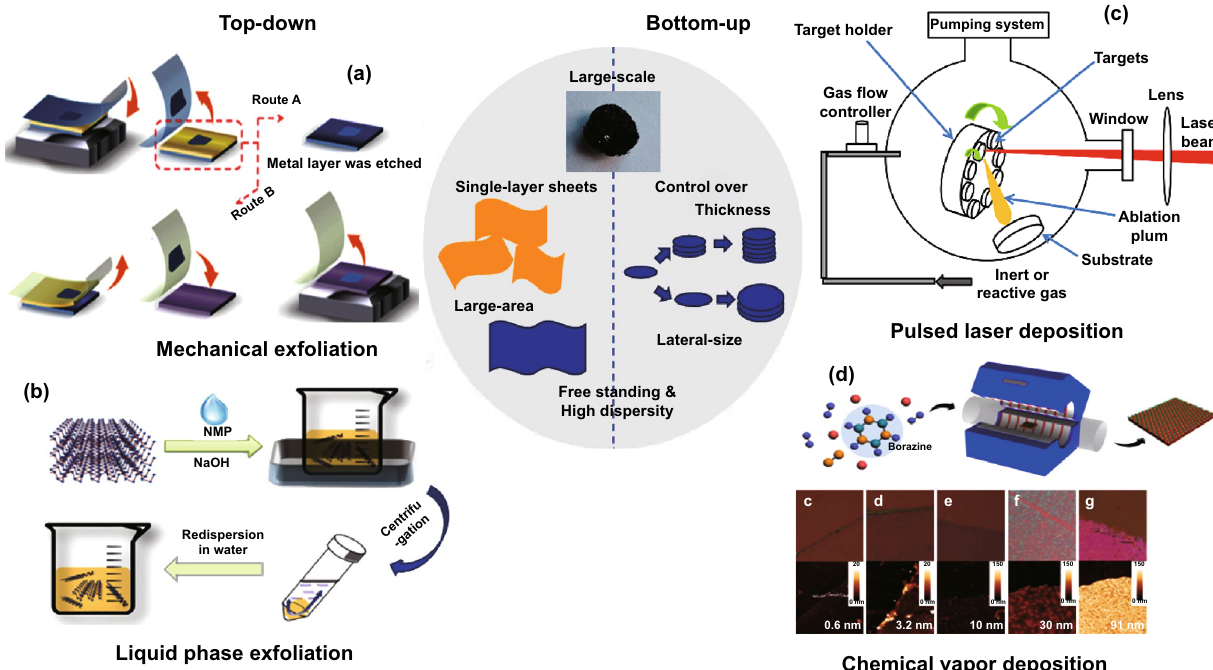
Fig. 3 Schematic description of several typical top-down and bottom-up synthetic techniques of a mechanical cleavage; reproduced with per- mission [92]. Copyright 2018 Royal Society of Chemistry; b liquid phase exfoliation; adapted with permission [106]. Copyright 2015 Wiley Publishing Group; c pulsed laser deposition; adapted with permission [148]. Copyright 2018 Frontiers; d chemical vapor deposition. Repro- duced with permission [135]. Copyright 2016 Nature Publishing